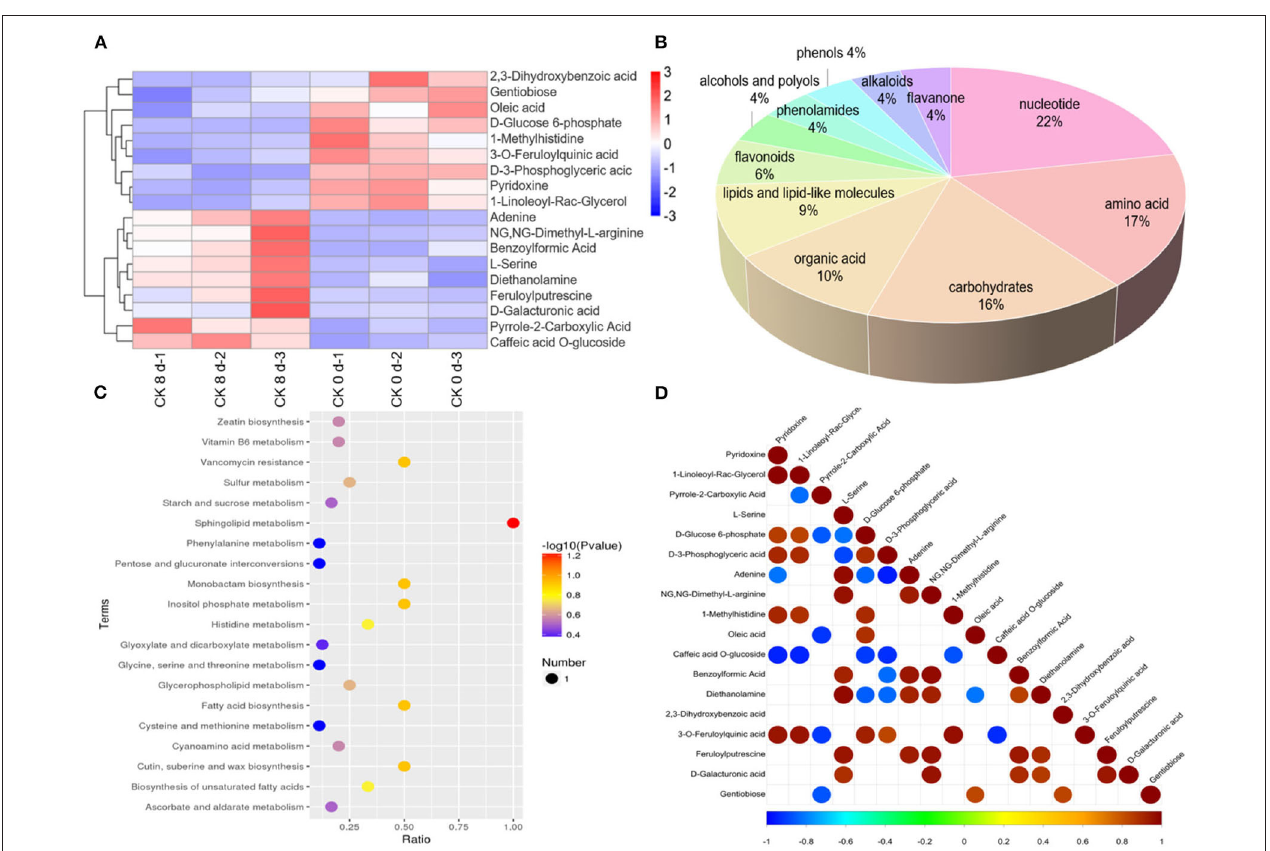
Frontiers in Nutrition |